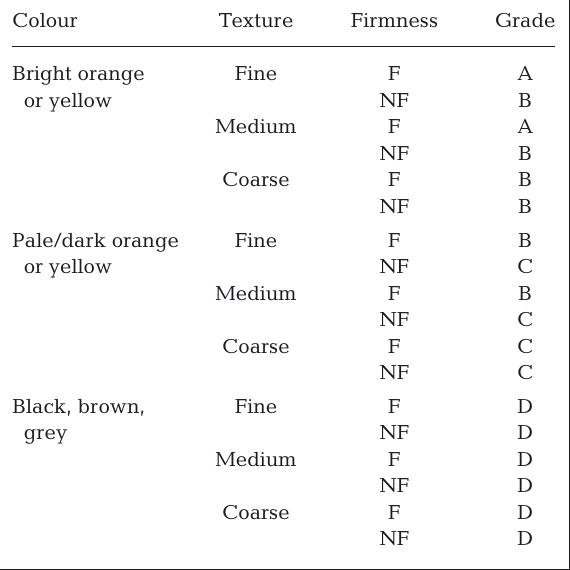
Fig. 1. Expt 2: grade system for assessing Heliocidaris erythro - gramma roe quality calculated from gonad colour, texture and firmness. (A) A-grade gonads, premium quality; (B) B- grade gonads, high commercial quality; (C) C-grade gonads, mediocre; (D) D-grade gonads, not of commercial quality. Scale in